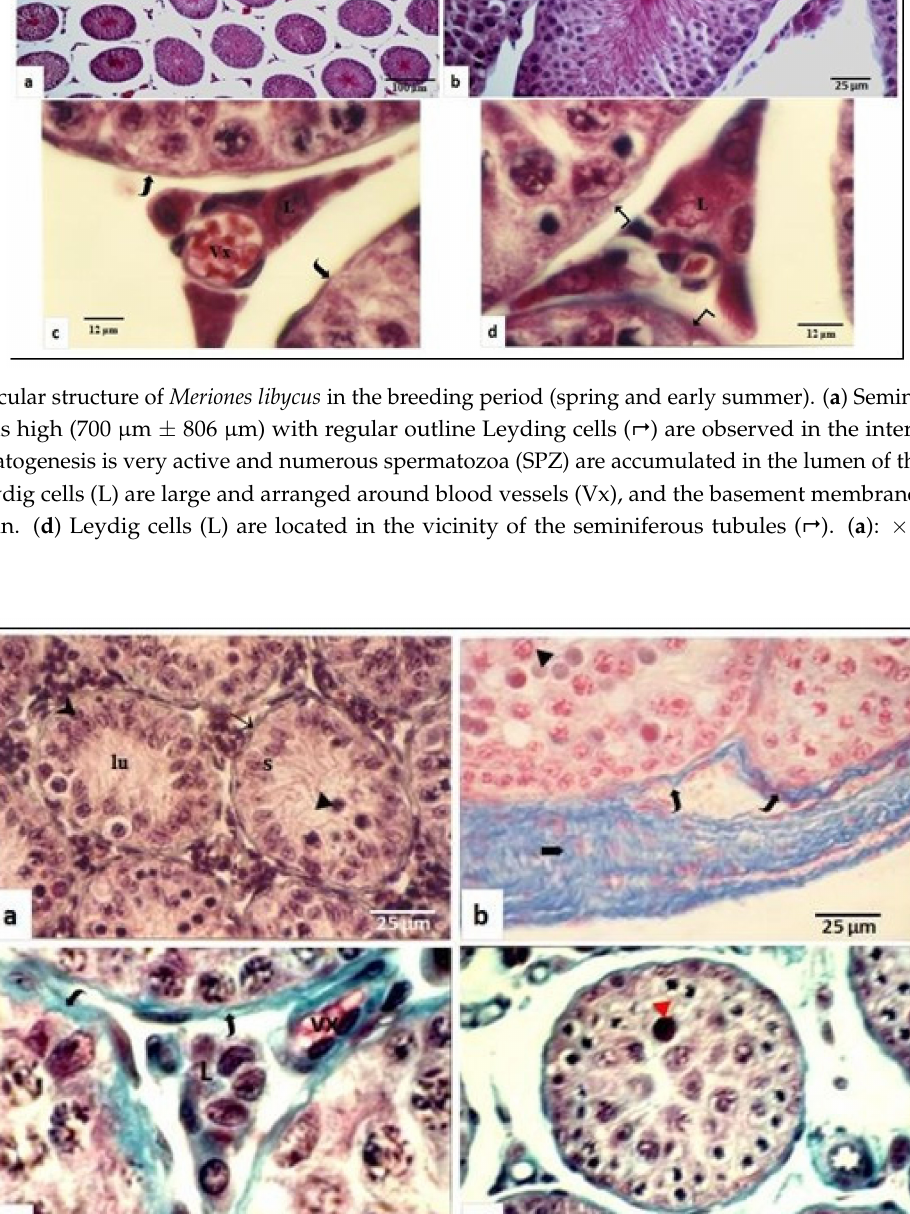
Figure 2. Testicular structure of Meriones libycus in the nonbreeding period (late summer, autumn, and late winter). ( a ) Seminiferous tubules ( → ) with a reduce diameter (300 ± 6.4 µ m) and an irregular contour, spermatogonia ( ) remain close to the basement membrane; the lumen (lu) does not contain any sperm, Sertoli cell nuclei (S) are moved away from the basement membrane, and some degenerated germ cells are observed ( ► ). ( b ) The basement membrane ( ) is thick and pleated and the tunica albuginea ( ) is greatly dense. ( c ) Leydig cell (L) are of greatly reduced size and seminiferous tubules are bordered by a deep basement membrane ( ). ( d ) Spermatogenesis stopped at the stage of spermatogonia and tubular lumen completely disappeared. a,b,d: ×400; c:×1250. In the breeding season, the seminal vesicles were abundantly filled with secretion (Figure 3a). They had numerous developed epithelial folds with a narrow axis where very few collagen fibers were housed (Figure 3b). They were bordered with a thin fi- bromuscular wall and separated from the epithelium by some sparse connective fibers (Figure 3c). The cylindrical epithelium was constituted with cells measuring 23 μ m ± 1.25 μ m in height with an abundant supranuclear cytoplasm without any specializations measuring 13 μ m ± 0.8 μ m (Figure 3b). During sexual quiescence, the seminal vesicles were strongly regressed, and in the widened axis of the epithelial folds was found a hypertrophied connective tissue (Figure 3d,e), and the fibro-muscular wall became irregular and well developed (Figure 3f). The epithelium was atrophied and was made up of cuboidal epithelial cells of only 11.6 μ m in height, with a reduced supranuclear zone measuring only 3.7 μ m ± 0.25 μ m (Figure 3e).